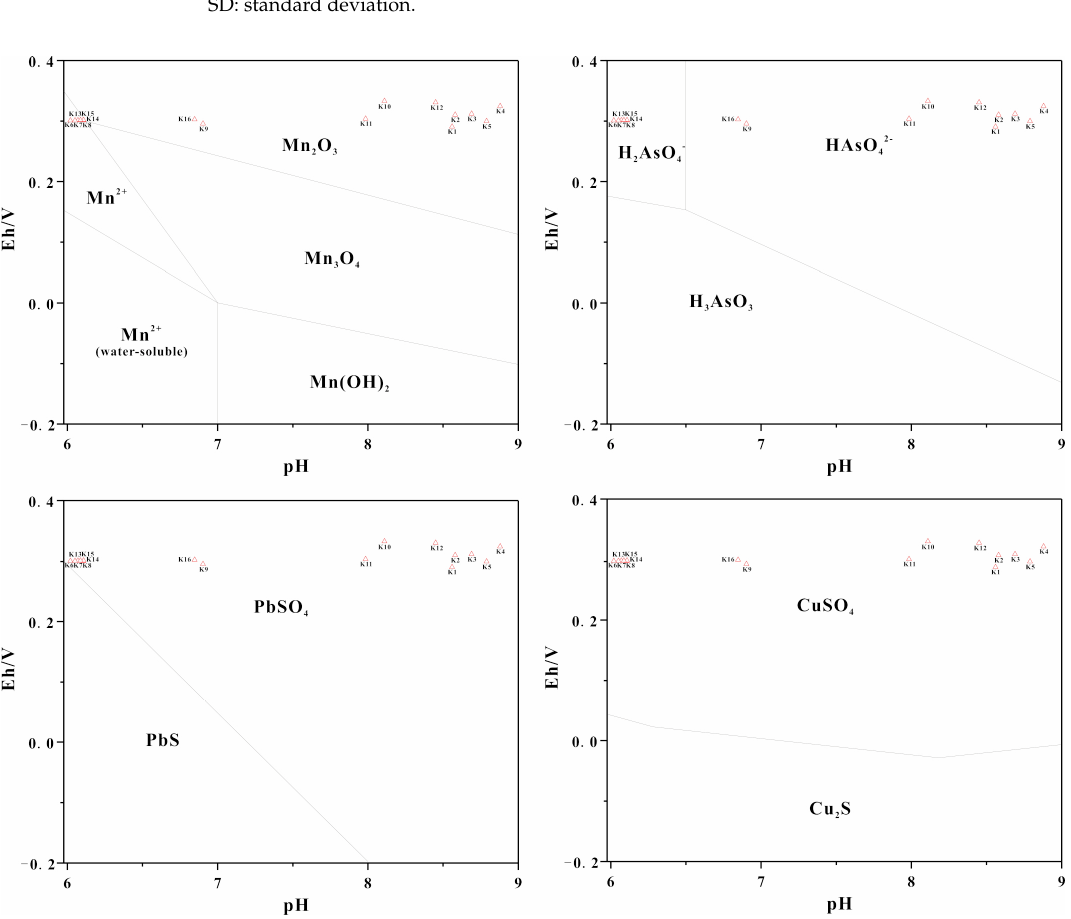
Figure 3. The stability fields of authigenic minerals as function of pH-Eh at 25 °C (modified from references [45–48]).